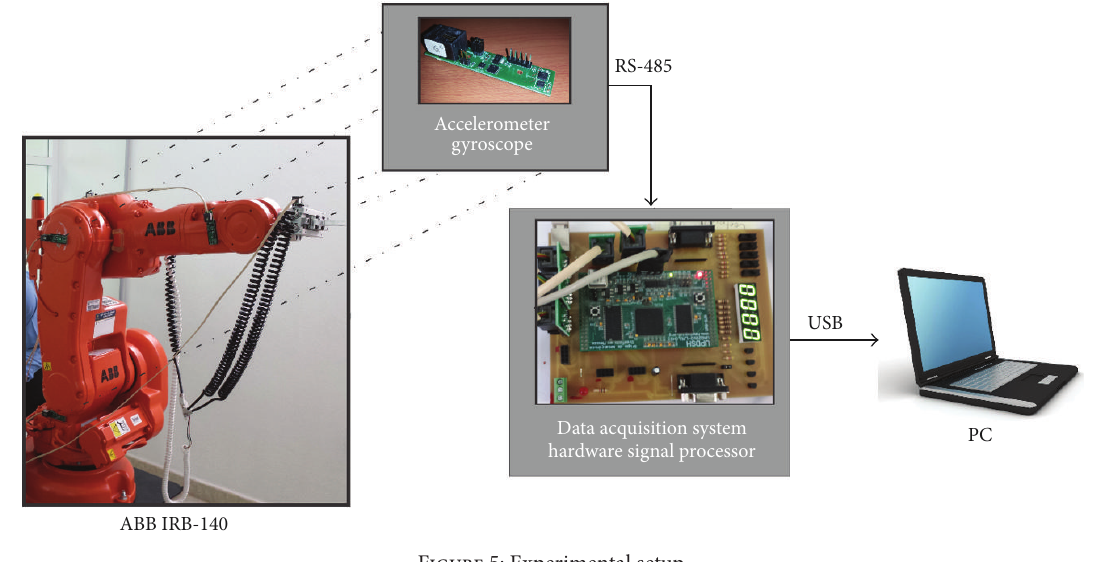
Figure 5: Experimental setup.